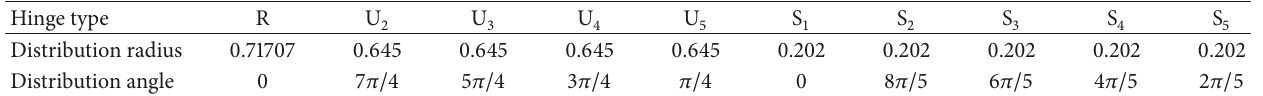
Figure 7: Calculation flow of dynamic model. Table 1: The distribution of joints of 4-UPS-RPS parallel mechanism (m).